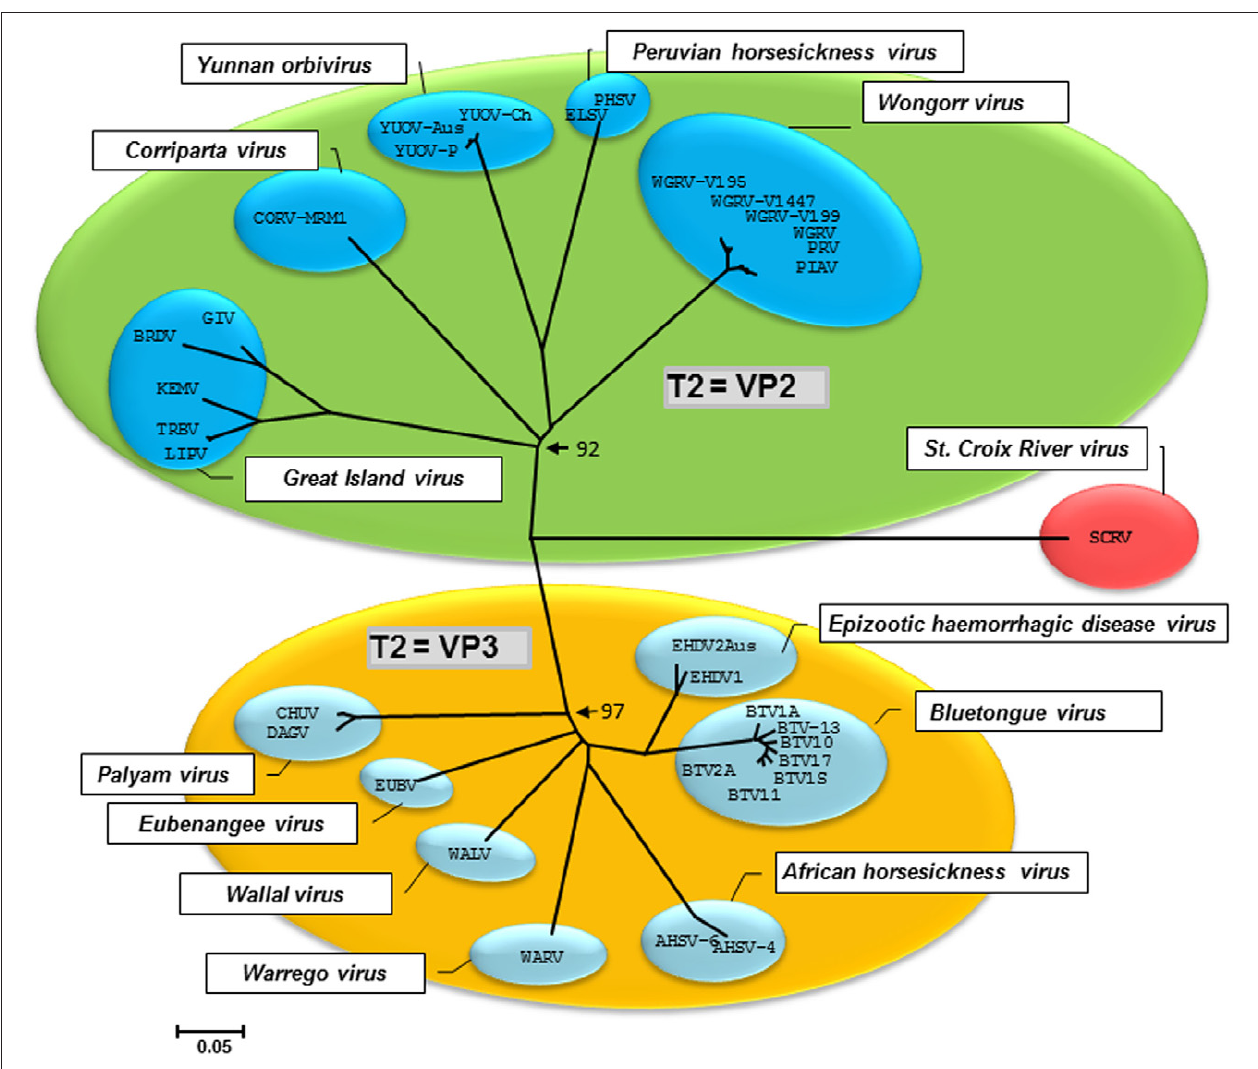
FIGURE 1 | Neighbor joining phylogenetic tree constructed using the subcore shell protein (T2 protein) of orbiviruses. The T2 protein of tick-borne and mosquito-borne orbiviruses (green group) is the VP2, while in midge-borne orbiviruses (yellow group) the T2 is VP3. SCRV (red) roots all